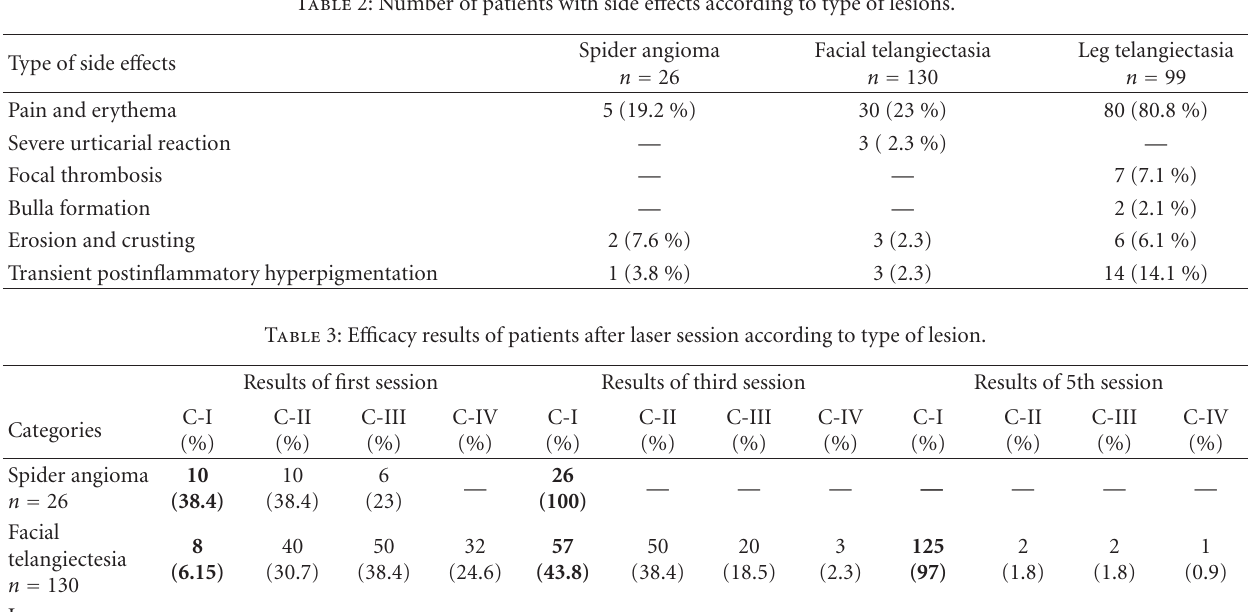
Table 2: Number of patients with side e ff ects according to type of lesions.